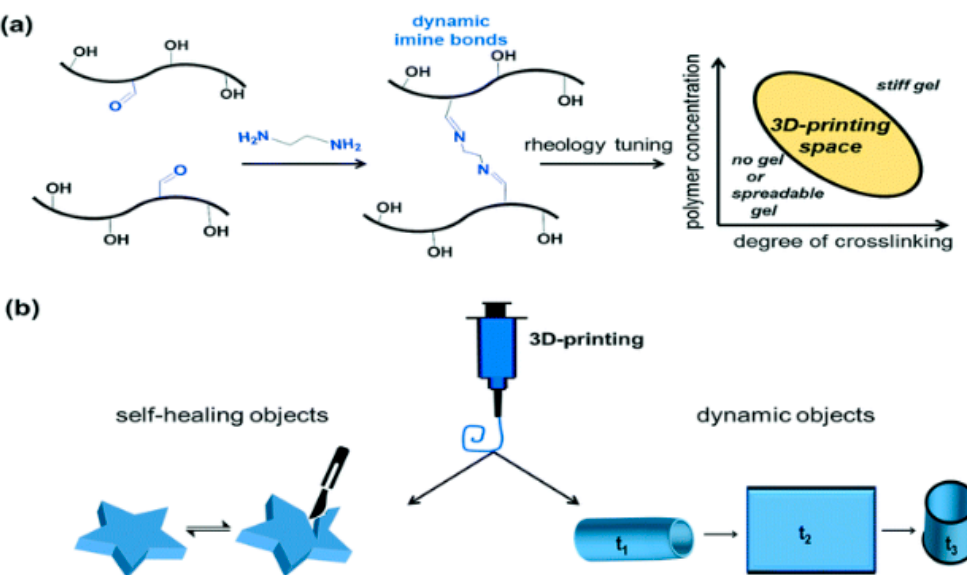
Figure 13. Schematic workflow for a 3D printable, self-healing working principle. ( a ) The first stage includes the synthesis and functionalization of PHEMA with pendant benzaldehyde groups, followed by a cross-linking with a diamine. The preparation of printable inks requires a delicate rheological tuning of ink formulations, and a mapping of the printability space. ( b ) After the optimization study was accomplished, selected formulations, which demonstrate a good balance between flow and self-support capabilities, were 3D-printed. The objects dis-play self-healing and dynamic properties. (Reprinted with permission from [49]. Copyright Royal Society of Chemistry, 2017).